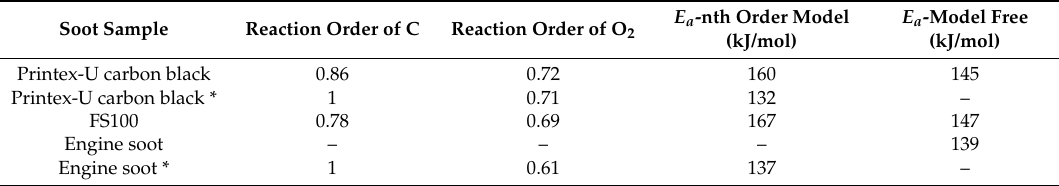
Figure 10. Arrhenius plots for non-catalytic oxidation of flame soot FS100. Table 3. Kinetic parameters for the non-catalytic combustion of Printex-U carbon black, flame soot FS100, and real engine soot.